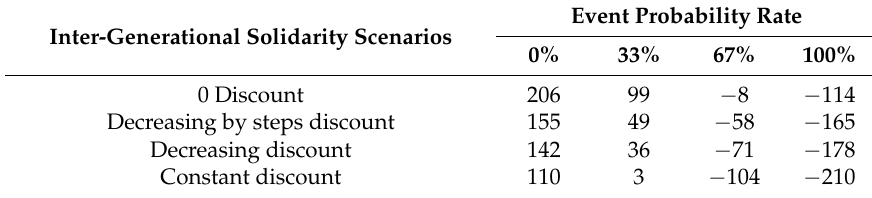
Table 1. Differences between the value of territory safety e and the recovery cost value c under four discounting scenarios and four event probability rates